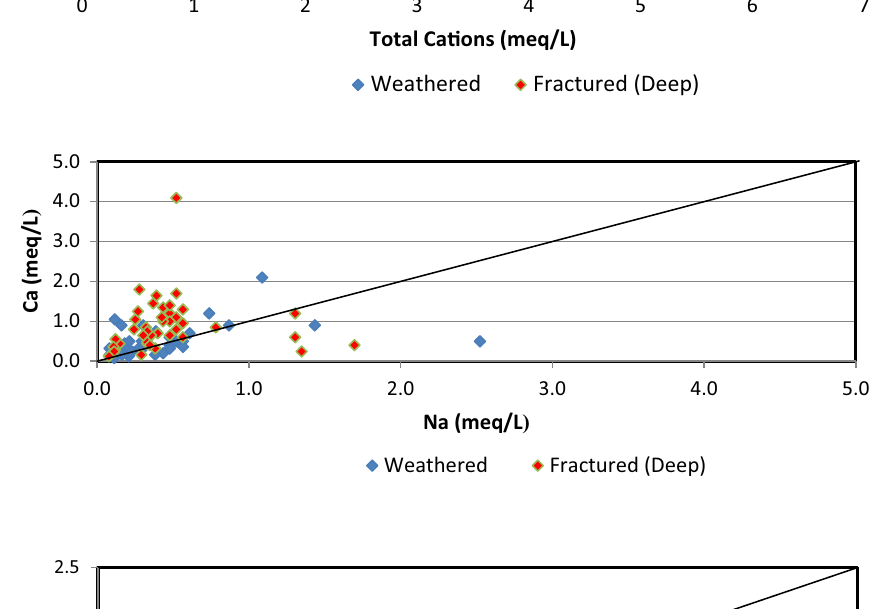
Fig. 10 Plots of Na versus